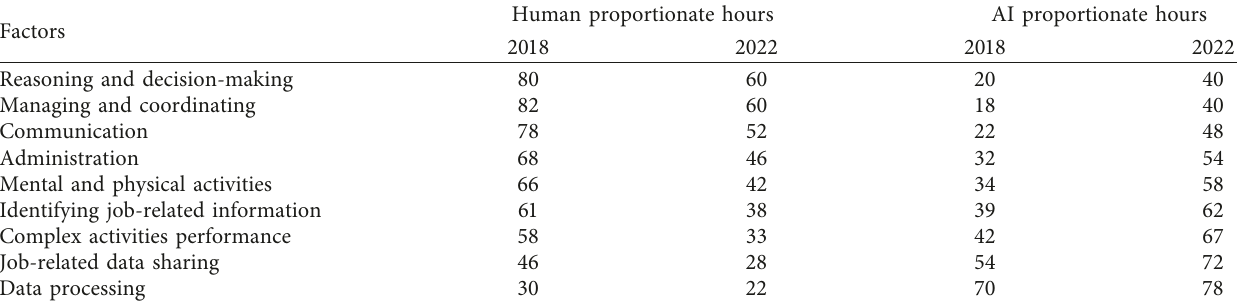
Table 5: Effectiveness of AI tools in firm decision-making